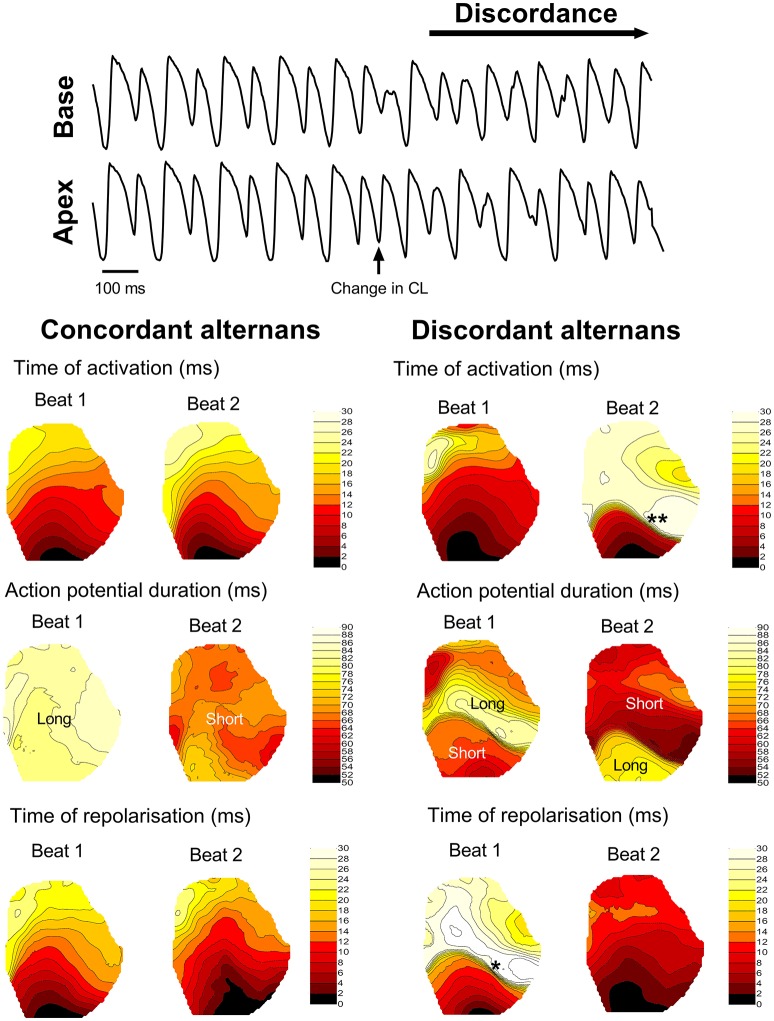
Transition from concordant to discordant alternans. Illustrative example of the transition from concordant to discordant alternans during dynamic pacing in the guinea pig heart. Representative traces from basal and apical regions are shown, along with representative isochronal maps of activation time, regional action potential duration and total repolarisation time across the guinea pig left ventricle during concordant and discordant alternans. Beats or regions with relatively long or short action potentials are labeled. *denotes a region of tissue with a steep repolarisation gradient, secondary to discordant alternans, that results in regional condition slowing (**) on the next beat.